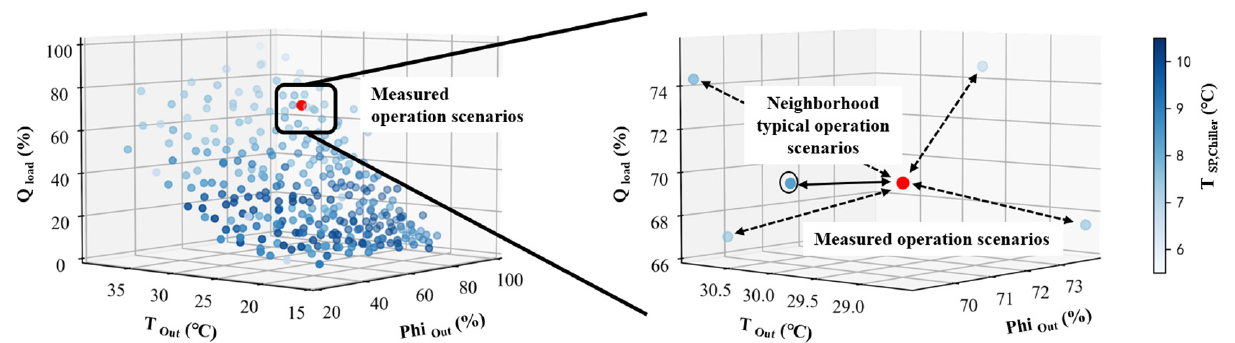
Figure 6. Diagram of searching for the optimal setpoints using the lookup table (The line between operation scenarios indicates the distance between similar scenarios, and the solid line connects the most similar combinations).